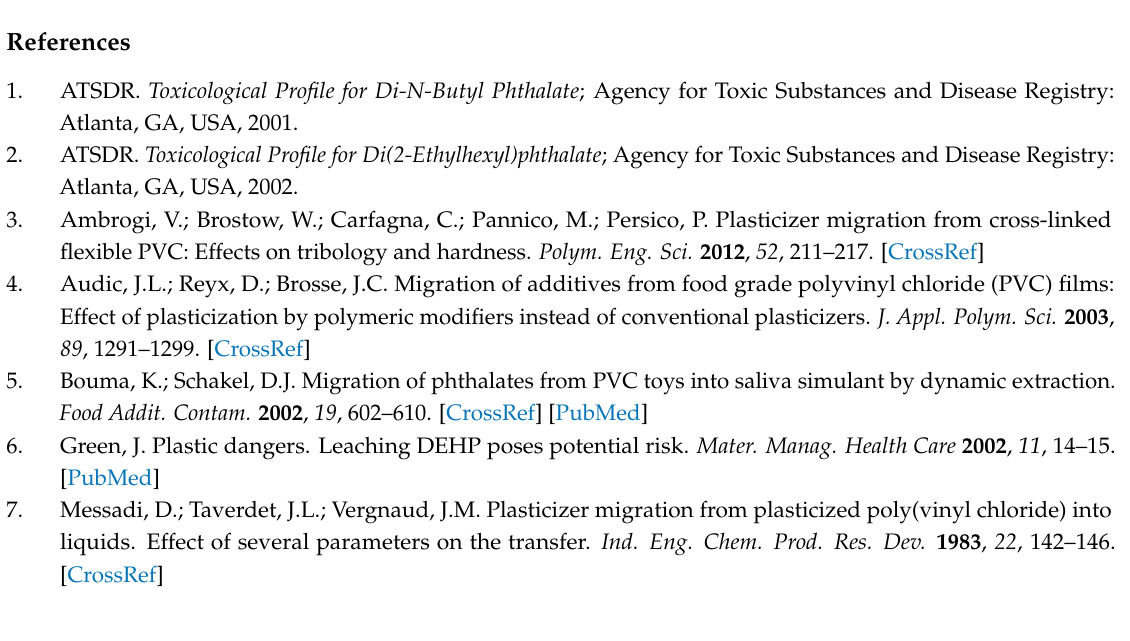
Table S1: Oral exposure and hazard quotient calculation for phthalates in children’s toys, Table S2: Dermal exposure and hazard quotient calculation for phthalates in children’s